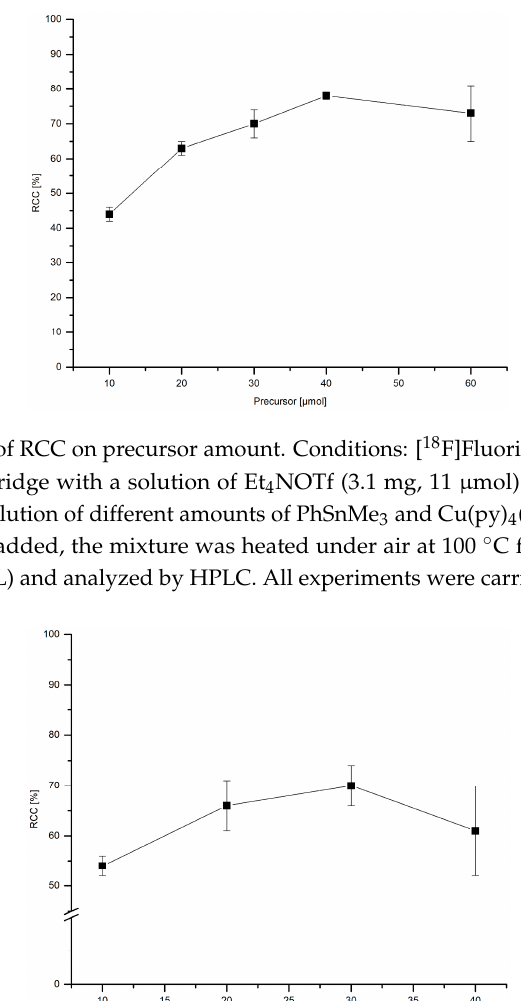
Figure 9. Dependency of RCC on precursor amount. Conditions: [ 18 F]Fluoride (~50 MBq) was eluted from a QMA-CO 3 cartridge with a solution of Et 4 NOTf (3.1 mg, 11 µmol) in n BuOH (300 µL) (see